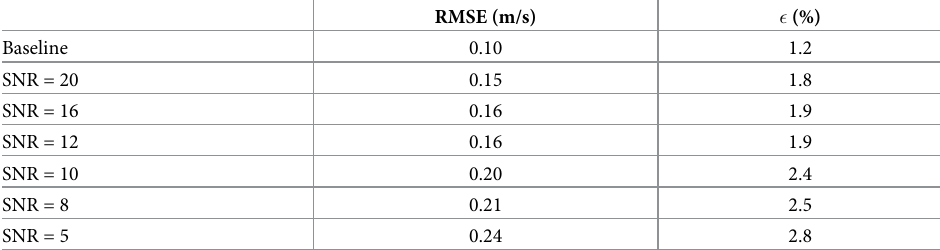
Table 3. Root mean square error (RMSE) and percentage error ( � ) for the pulse wave velocity (PWV) estimation from the radial pressure wave by the recurrent neural network (RNN), with different intensities of added white